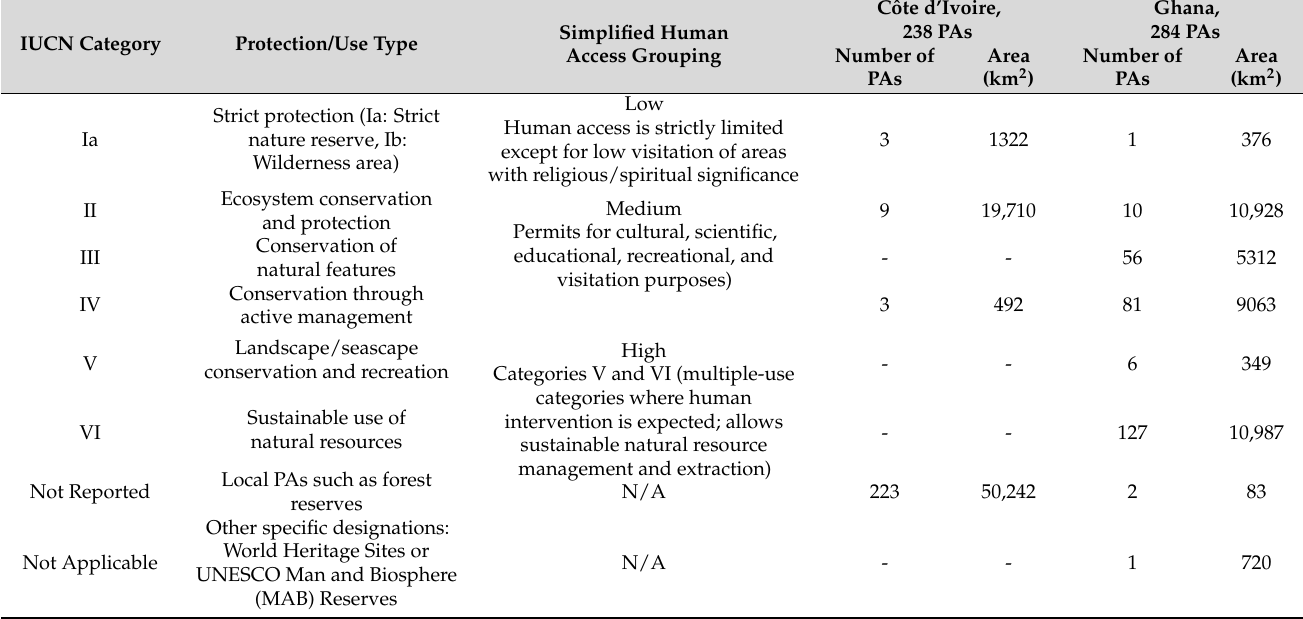
Table 2. Protected area (PA) IUCN classification, protection type, and human access grouping with the number and total area of each identified in C ô te d’Ivoire and